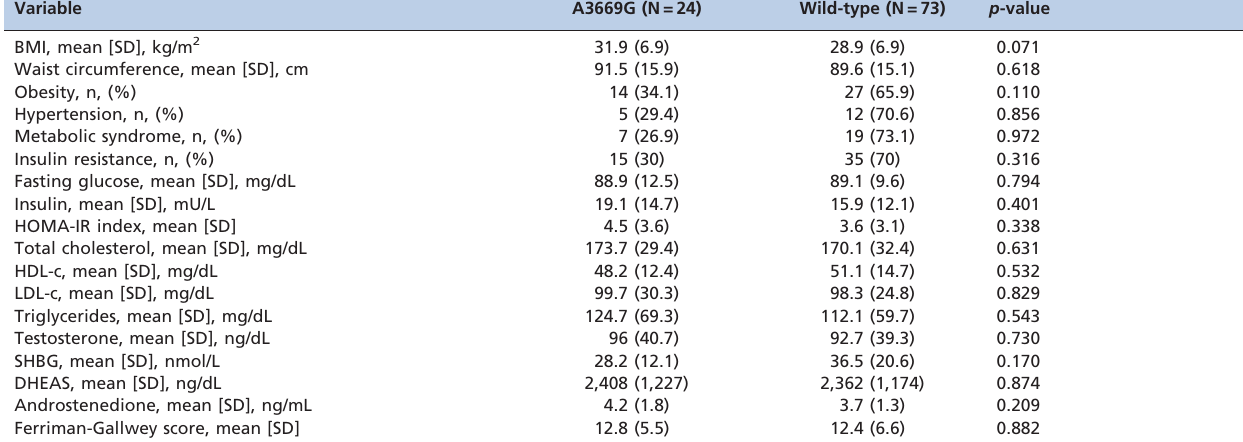
Table 3 - Influence of the A3669G polymorphism on the clinical, hormonal and metabolic profiles of patients with polycystic ovary